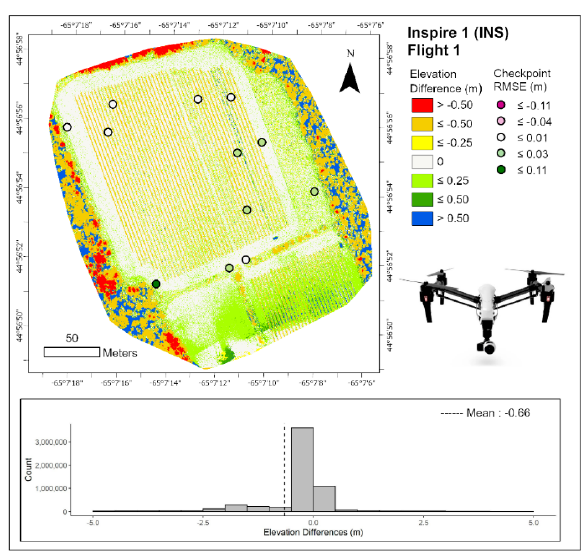
Figure 4. DSM of Difference (DoD) between the Inspire 1 (INS) (flight 1) and the LiDAR DSM. The dashed line represents the mean error of − 0.66 m.